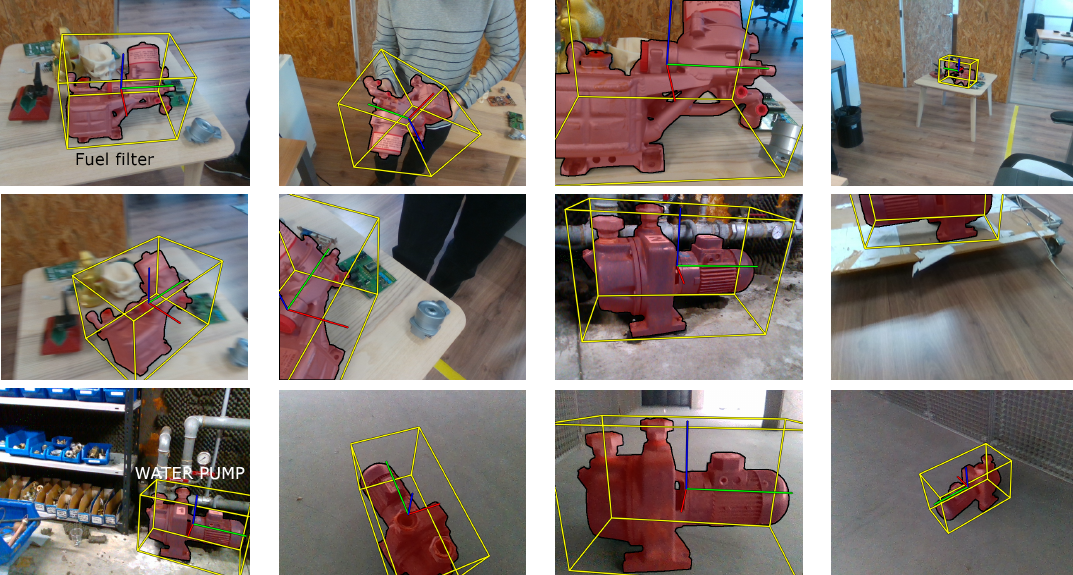
Figure 9. Qualitative results of the pose estimation method implemented in this work for different 3D models. The red color of the 3D model indicates the projection of the 3D model on the 2D image with the obtained